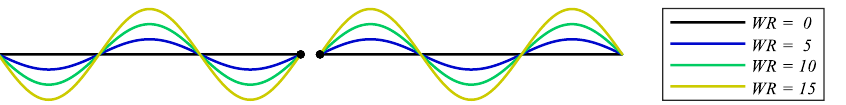
Figure 6. Representation of increasing WR of an example antenna with n = 3, while keeping L A as constant and ignoring the fixed wire length L W constraint.